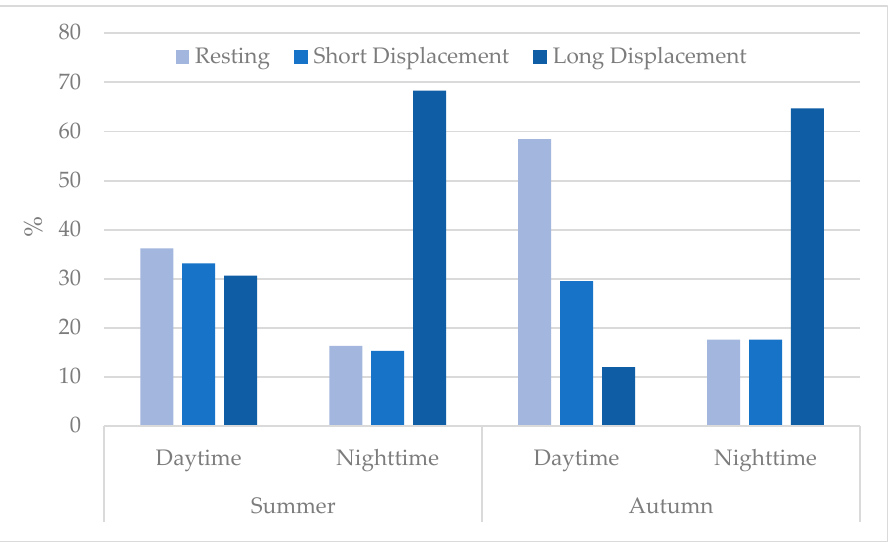
Figure 6. Percent (%) of time spent in three types of non ‐ active/active behaviours computed by season and phase of the day: (a) resting, in the case of displacements <50 m in one hour; (b) short displacement, between 50 and 500 m in one hour; (c) long displacement, larger than 500 m in one hour.